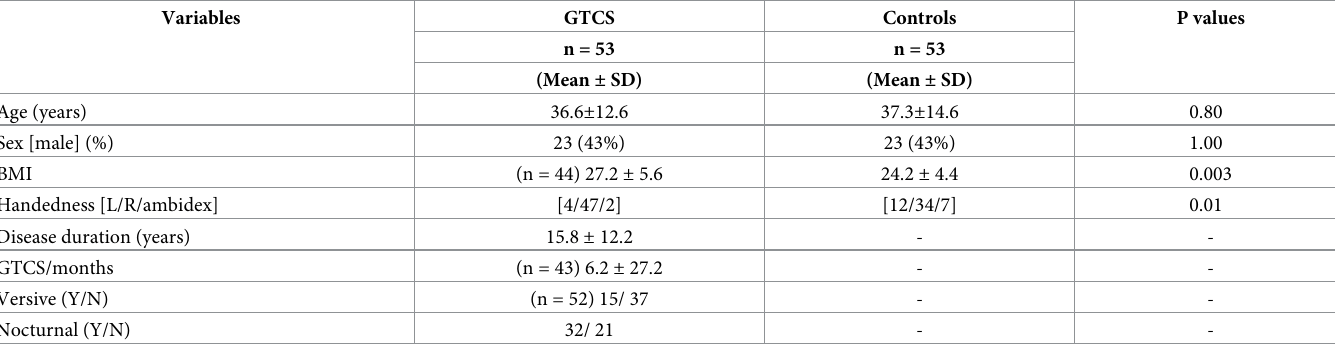
Table 1. Demographics and clinical characteristics of GTCS patients and control